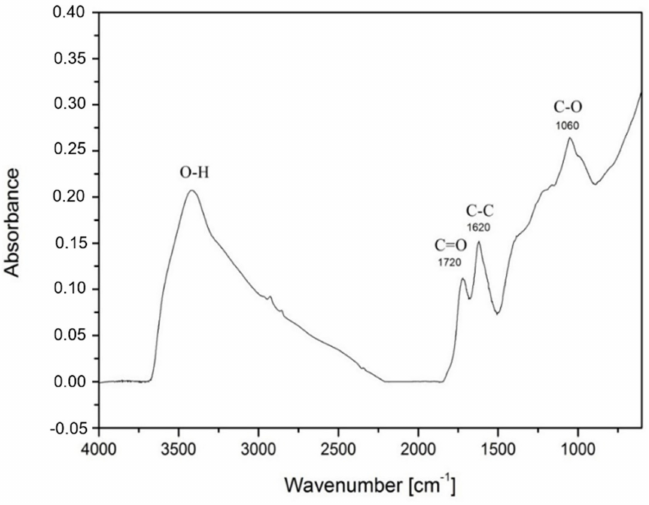
Figure 4. FTIR spectrum of GO prepared by Hummers